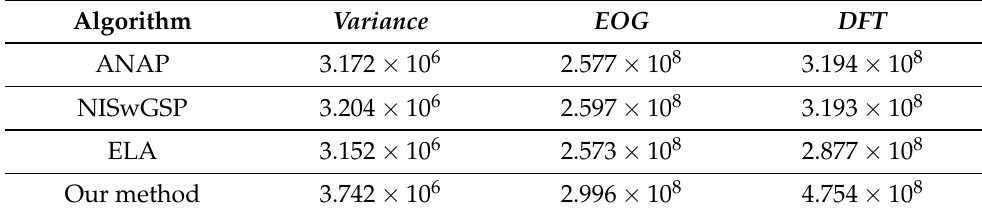
Table 1. comparison of the evaluation indicators among four